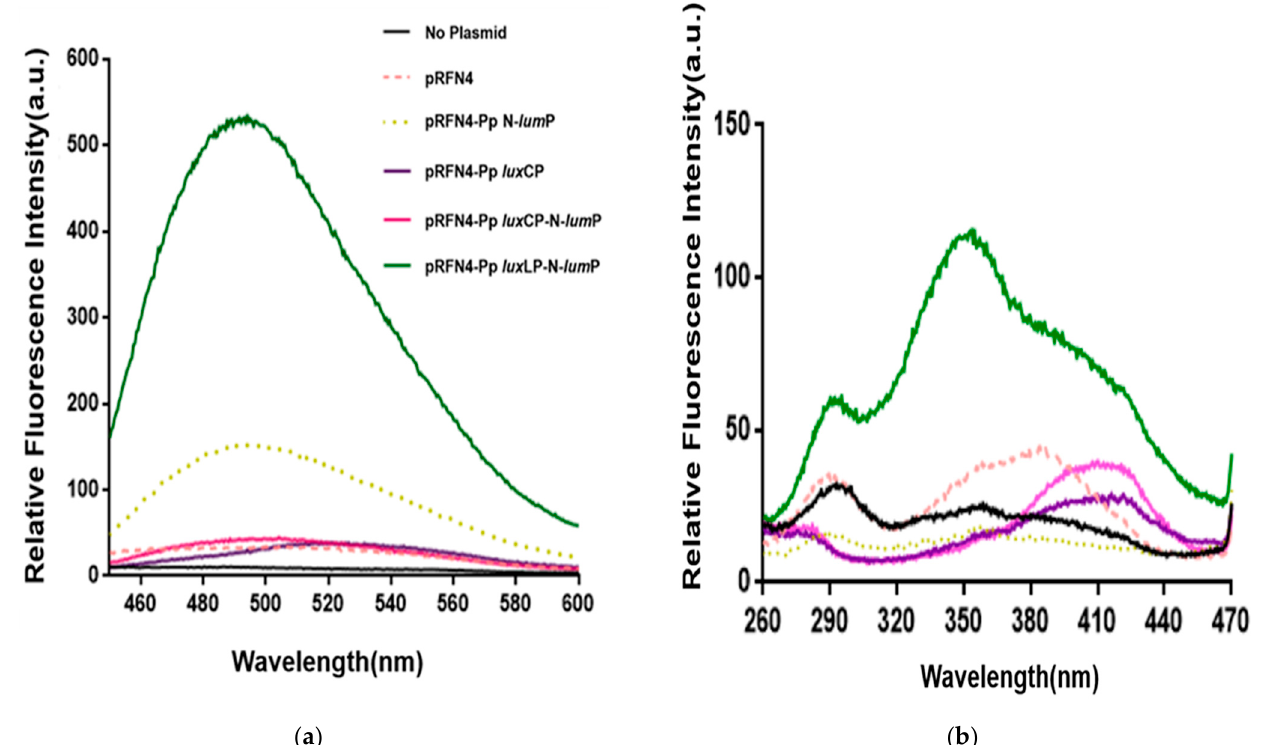
Figure 7. Fluorescence spectra of E. coli 43R transformed with recombinant pRFN4 plasmids containing P. phosphoreum lux DNA. ( a ) Emission spectrum in fixation at excitation wavelength of 410 nm. ( b ) Excitation spectrum for emission at 490 nm.